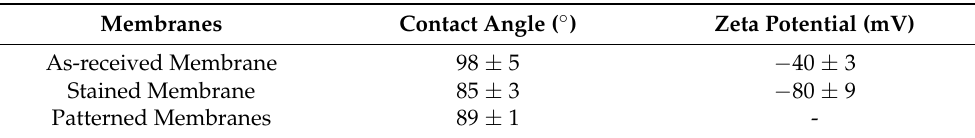
Figure 9. Intensity and areal mass values for confocal laser scanning microscopy (CLSM) images presented in Figures 7 and 8. Each point represents a different membrane sample. Error bars represent ± 1 ơ on three images from each sample. Table 3. Membranes surface characteristics. Each value represents the mean calculated from three measurements per sample, and the errors represent ±1 s.